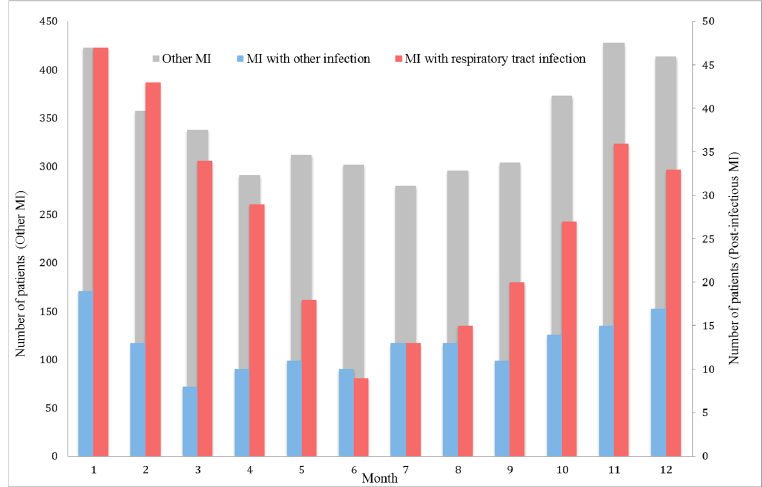
Figure 2. Incidence of post-infectious myocardial infarction (MI) and other MI per month of the year. Table 1. Patients characteristics on admission ( n (%) or median (IQR)).